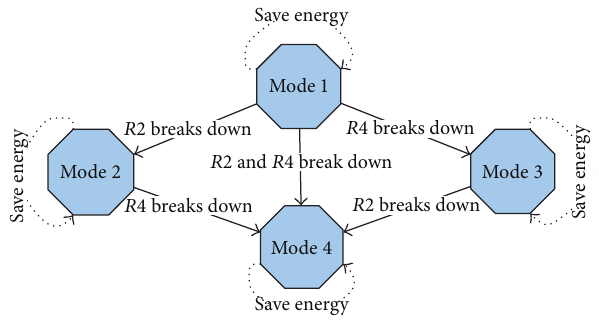
Figure 2: Possible reconfigurations in